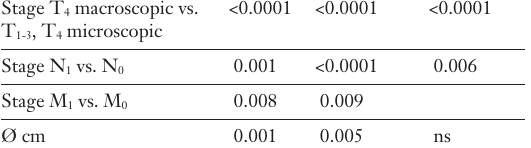
Treatment minimally invasive (n = 62) grossly invasive Follicular thyroid carcinoma (n = 115). } } } Primary treatment and outcome, by risk groups (no of patients [%]).